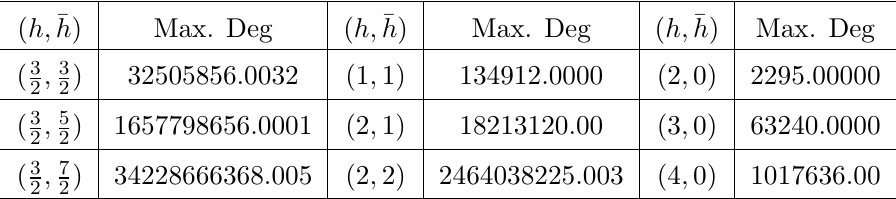
Table 13. This table summarizes the maximal degeneracy of (cid:12)rst few states in gapped c = 16 CFT. The total number of derivatives is set to N max = 55, while the spin is truncated at j max =